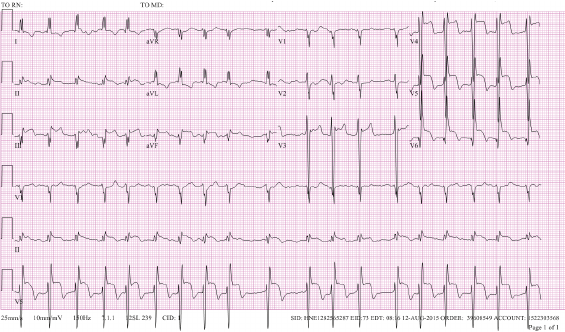
Figure 1: EKG showed atrial fibrillation with rapid ventricular response as well as ST elevations in leads II, III, aVF, and V3–V6.